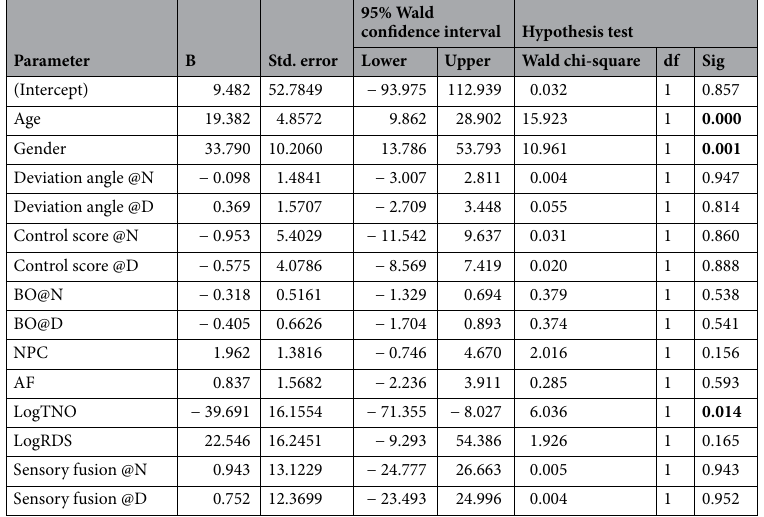
Table 2. Factors associated with the reading speed in IXT patients. N near, D distance, BI base out prism power for fusional vergence amplitudes, BO base out prism power for fusional vergence amplitudes, NPC near point of convergence, AF accommodative facility, TNO test for stereoscopic vision, a test for near stereo vision, RDS random dot stereo, a test for distance stereo vision. Bold mean p < 0.05 statistically